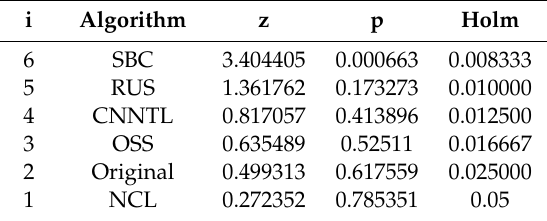
Table 23. Results of the Holm test comparing the performance of the Extended Gamma classifier after undersampling algorithms. The test rejects the hypothesis having an unadjusted p -value ≤ 0.01.